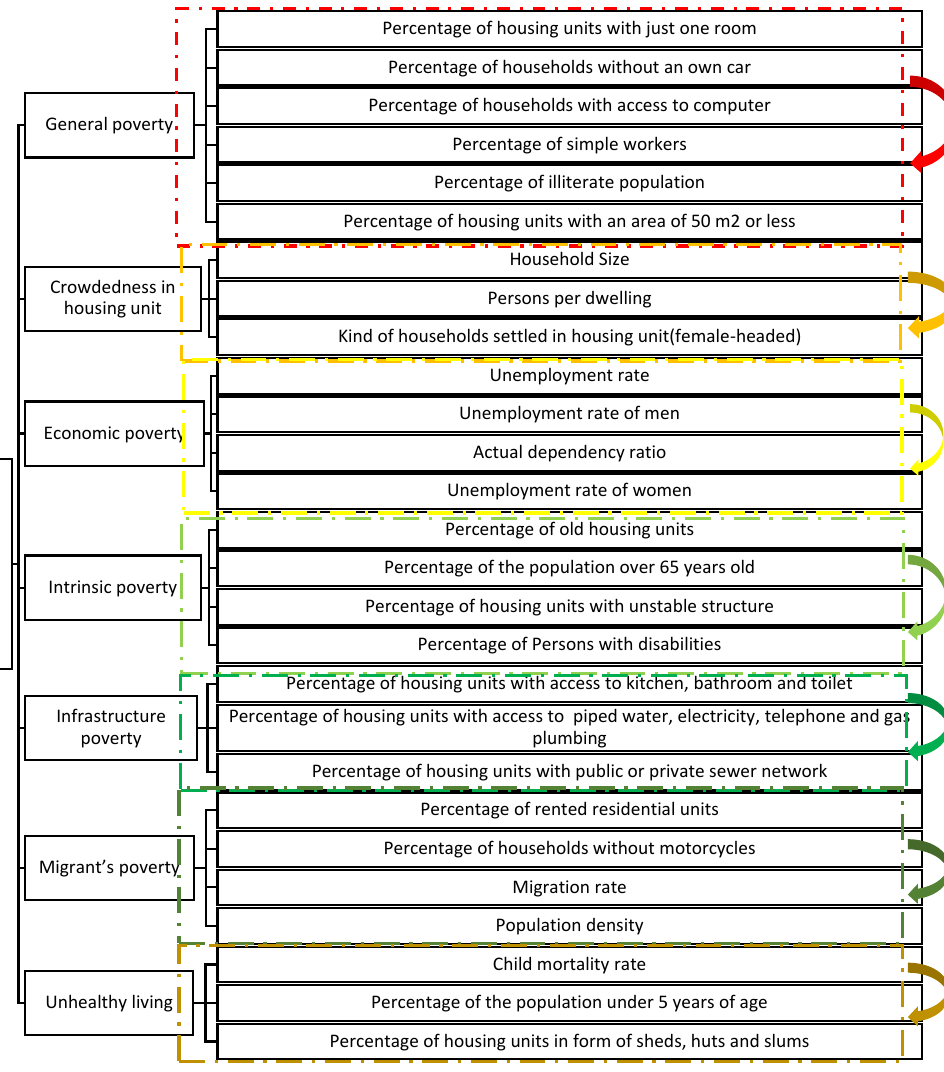
Fig. 5: The three-level network showing relationships among the indicators, criteria and goal